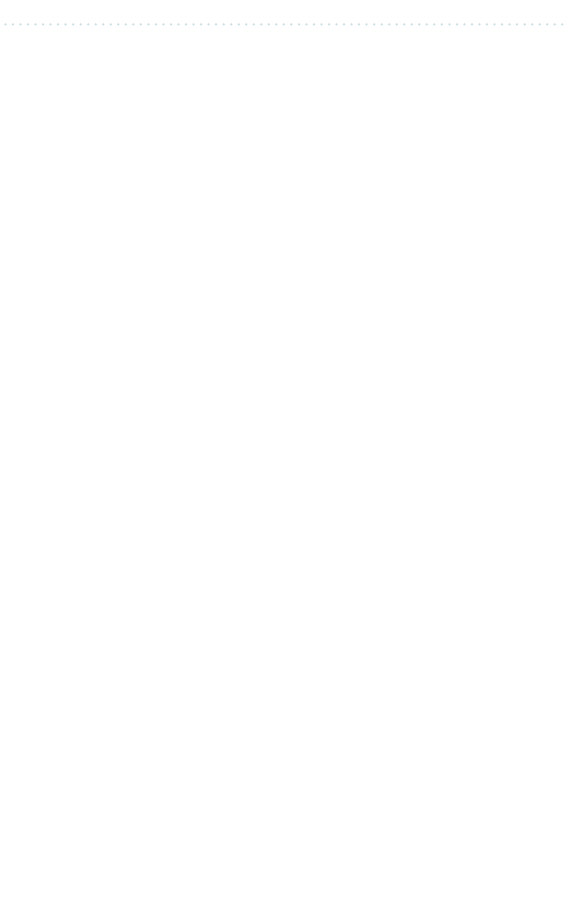
Table 4. Parameters that vary across the main scenarios discussed